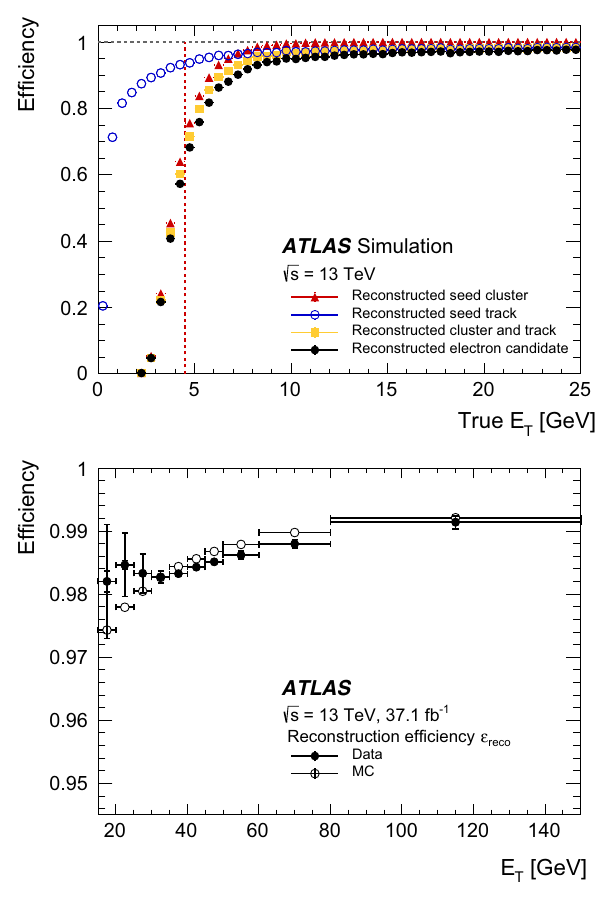
Fig. 2 Top: the total reconstruction efficiency for simulated electrons in a single-electron sample is shown as a function of the true (generator) transverse energy E T for each step of the electron-candidate formation: (cid:7)η × (cid:7)φ = 3 × 5 (in units of 0 . 025 × 0 . 025) seed-cluster reconstruc- tion(redtriangles),seed-trackreconstructionusingtheGlobal χ 2 Track Fitter (blue open circles), both of these steps together but instead using GSF tracking (yellow squares), and the final reconstructed electron can- didate, which includes the track-to-cluster matching (black closed cir- cles). As the cluster reconstruction requires uncalibrated cluster seeds with E T > 2 . 5 GeV, the total reconstruction efficiency is less than 60% below 4 . 5 GeV (dashed line). Bottom: the reconstruction efficiency rel- ative to reconstructed clusters, (cid:10) reco , as a function of electron transverse energy E T for Z → ee events, comparing data (closed circles) with simulation (open circles). The inner uncertainties are statistical while the total uncertainties include both the statistical and systematic com-